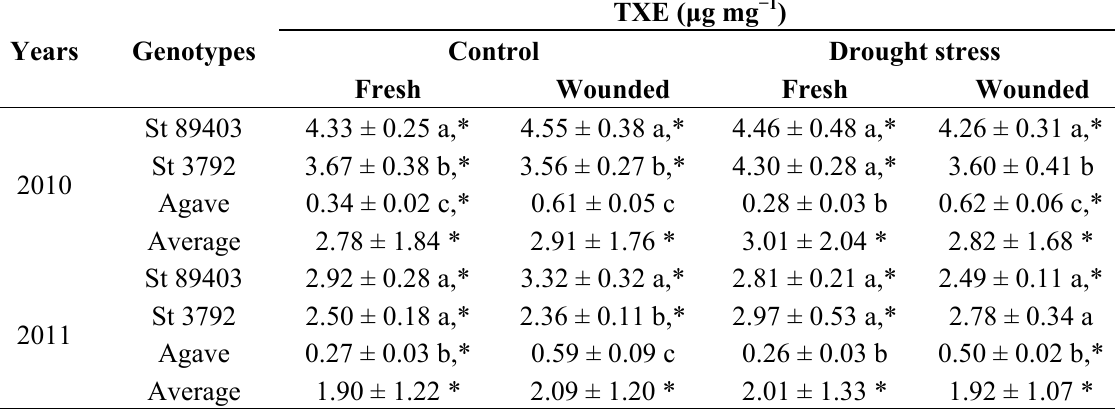
Table 6. Antioxidant activity measured as trolox equivalent (TXE) in fresh tissue and 24 h after wounding the control and drought stressed tubers grown in 2010 and 2011 (Mean ± SD; n =